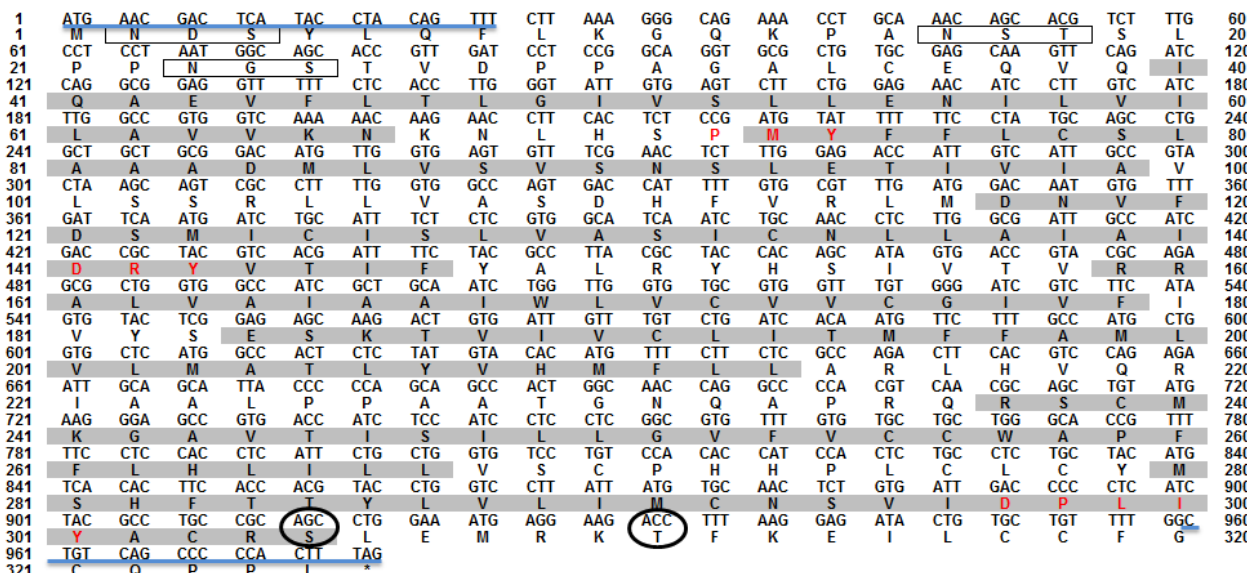
Figure 1. Nucleotide and deduced amino acid sequence of omMc3r. The positions of nucleotides and amino acids are marked on both sides. Gray shading indicates the seven-transmembrane domain (7TMD). Red letters highlight the conserved motifs (PMY, DRY, and DPLIY). Solid black boxes frame the N-glycosylation sites. Black circles represent the phosphorylation sites at the C-terminus. Asterisk (*) denotes a stop codon. The primer pairs utilized for amplification are shown by the blue line.